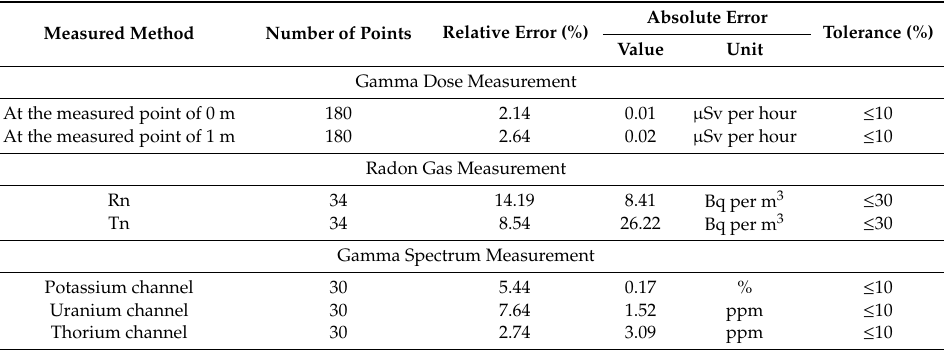
Table 1. Error assessment of measured results in